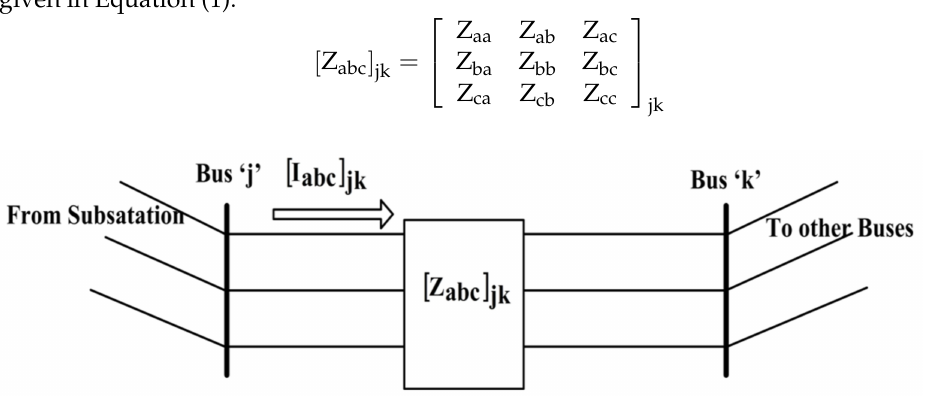
Figure 1. A sample three-phase distribution